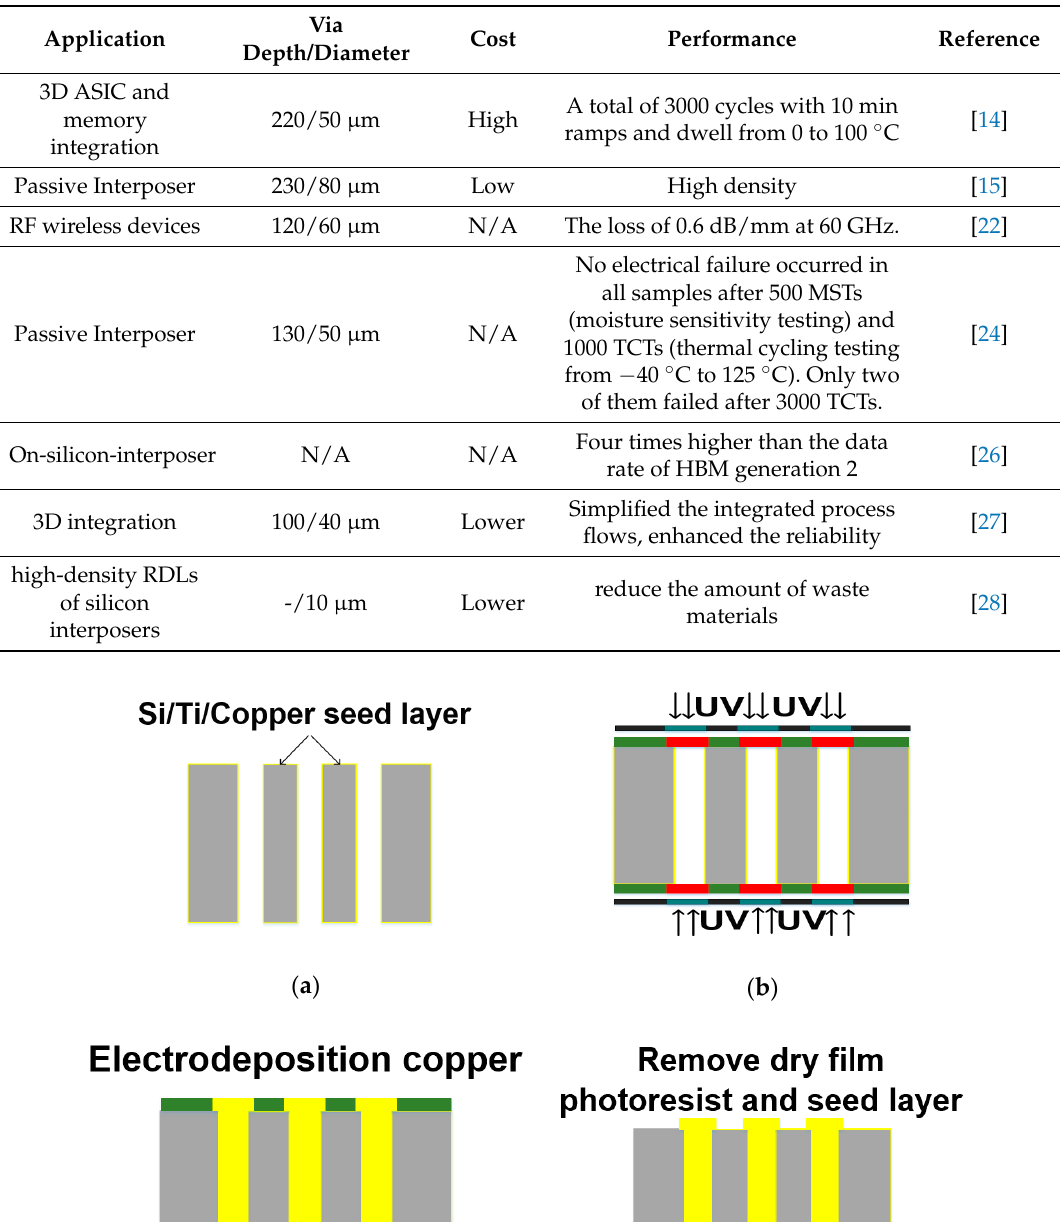
Table 1. Summary of methods to metallize TSVs.